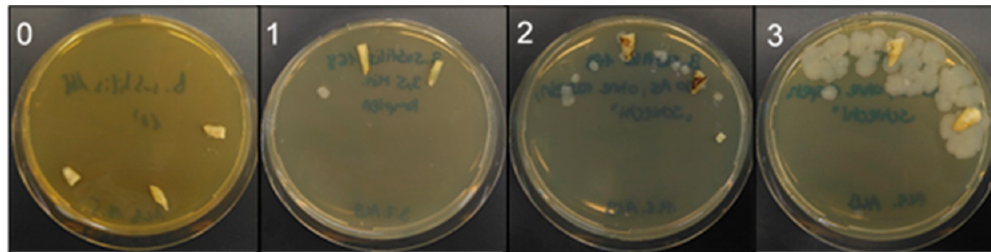
Figure 6. Evaluation scheme for bacterial growth following BDD electrode treatment. Split teeth were impressed on BHI agar plates and incubated overnight at 30 °C. Bacterial growth was scored from 0 = no bacterial growth, 1 = moderate bacterial growth, 2 = medium bacterial growth, and 3 = strong bacterial growth.